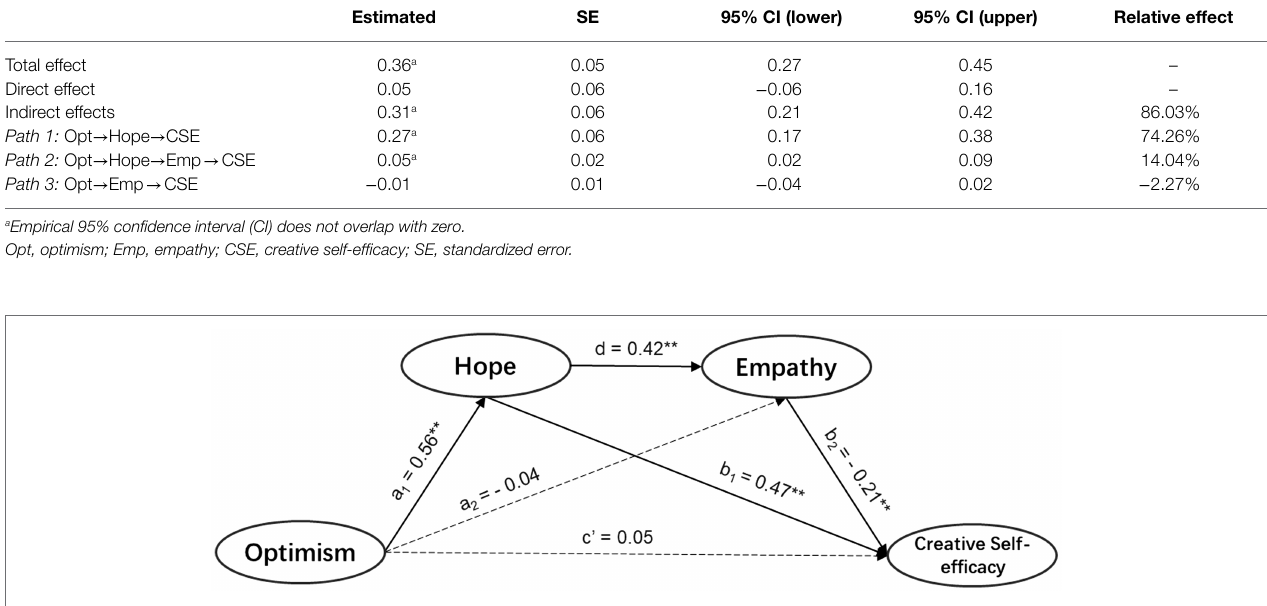
FIGURE 2 | Path diagram of modified mediation model linking optimism and CSE through hope and empathy. A dashed line suggests a non-significant relationship between the two variables, while a solid line suggests a significant relationship. All the path coefficients were standardized. N = 330. ** p <